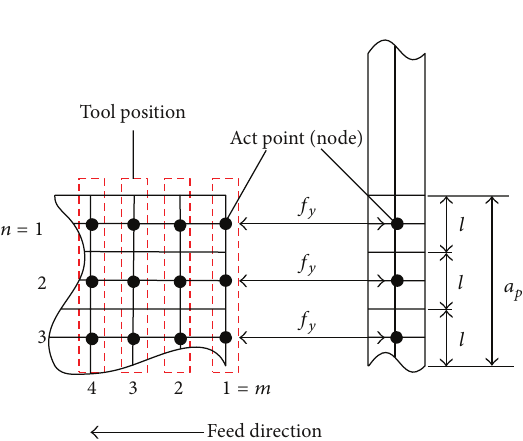
The start angle and exit angle under up-milling and down-milling can be separately expressed by 𝜙 = 0, st